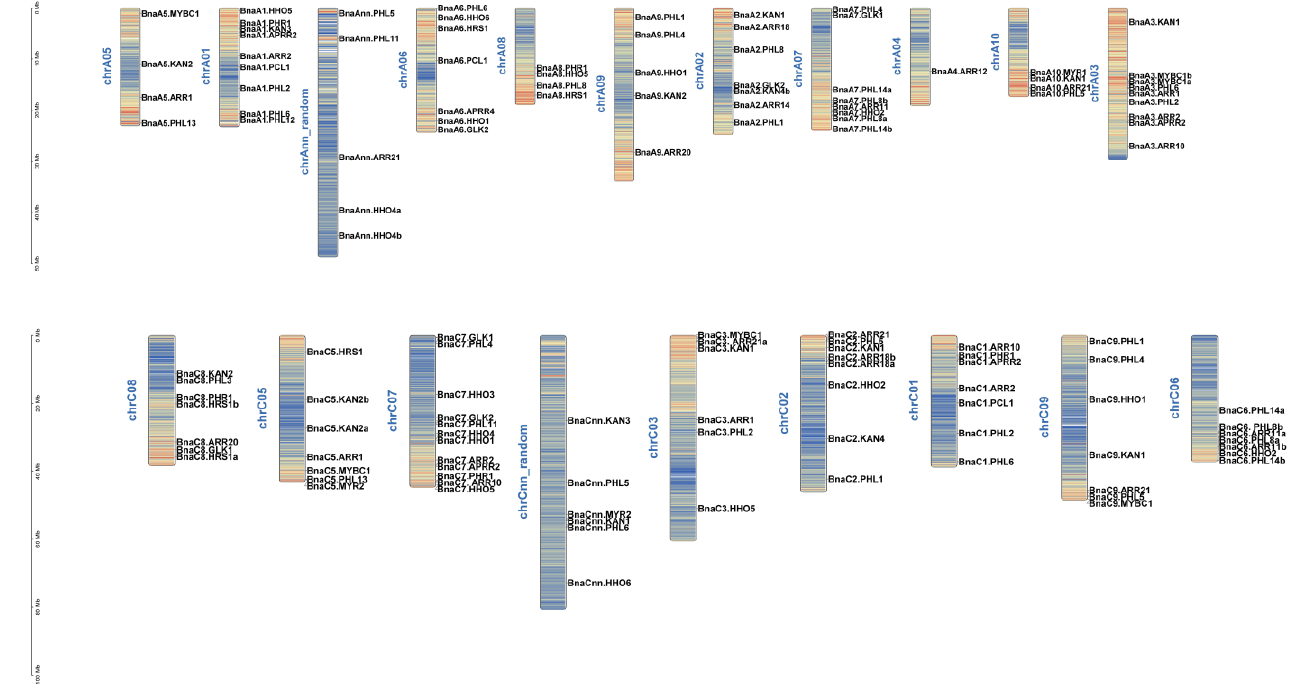
Figure 4. Chromosomal location of the 146 genes in GARP family genes in B. napus . The distribu- tion of the 146 genes on the 20 chromosomes is presented. The Ann and Cnn chromosomes refer to the chromosome that is anchored to the A and C subgenomes, while they have been not the specific chromosome.